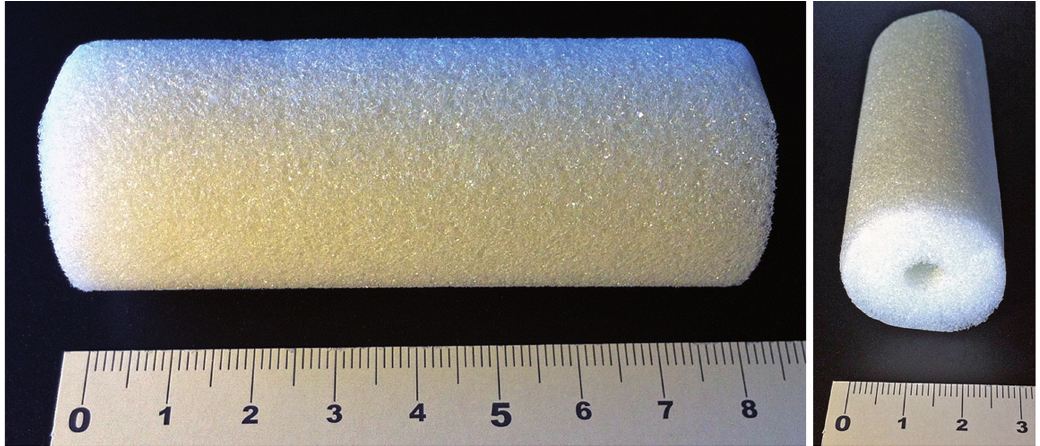
Figure 1 - The absorbable hemostatic gelatin sponge (SPONGOSTAN TM Anal) made of gelatin is cylindricality-shaped of 3 cm (diameter) X 8 cm. In the center, it has a cylindrical hollow region of 0.8 cm in